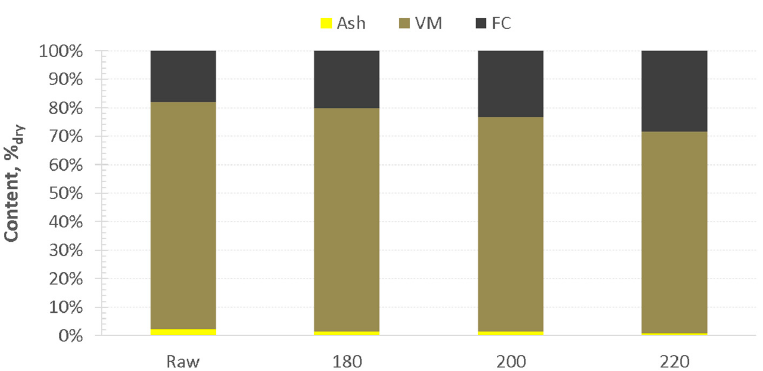
Figure 5. Ash yield for the performed HTC experiments.